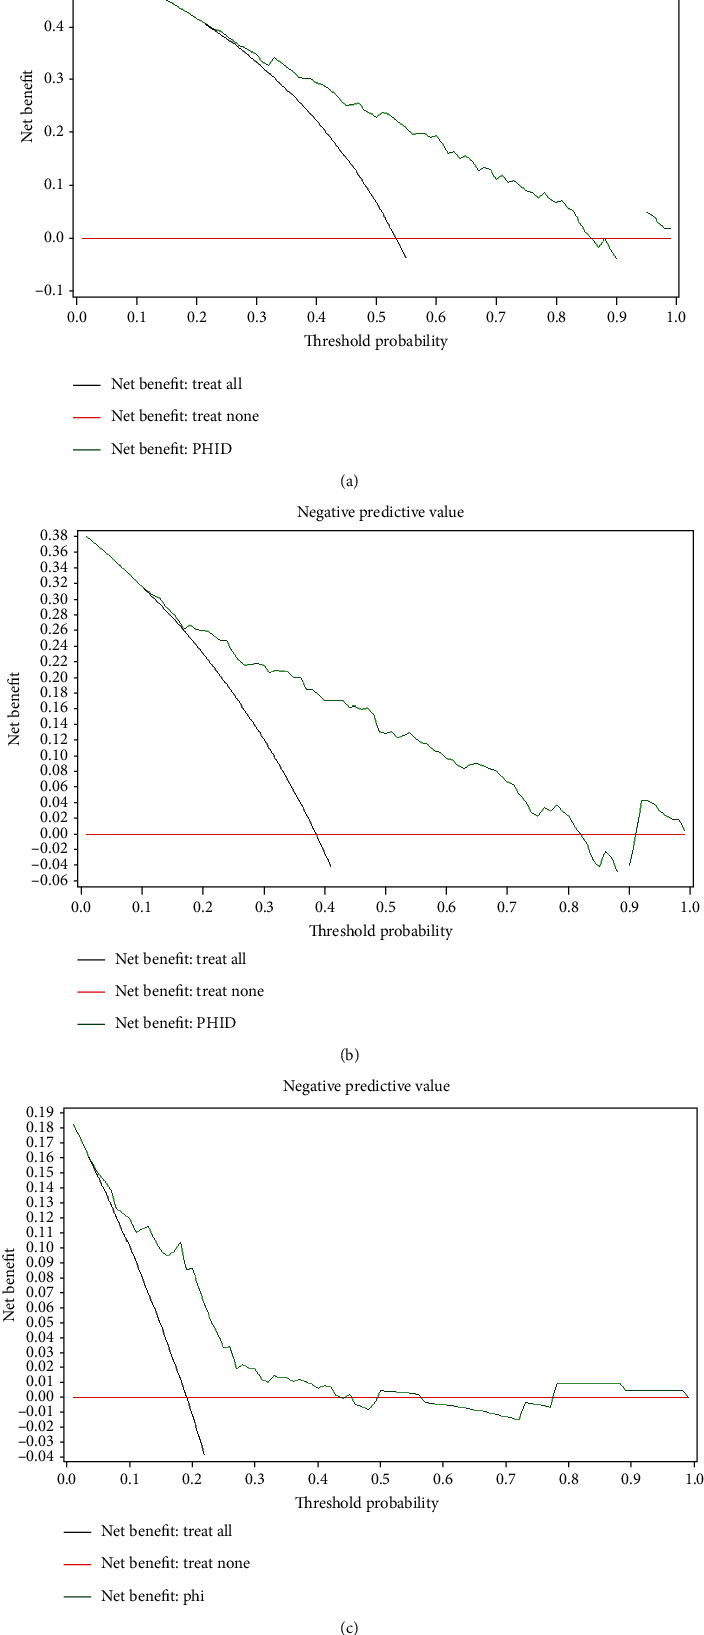
Decision curve analysis for prostate cancer biomarkers that have demonstrated the best net benefit (a) for prediction of overall, (b) for prediction of Epstein significant, and (c) for prediction of ISUP ≥2 prostate cancer. The net benefit is plotted against the threshold probability. The unit of net benefit is true positives. Abbreviations: phi: Prostate Health Index; PHID: phi density.